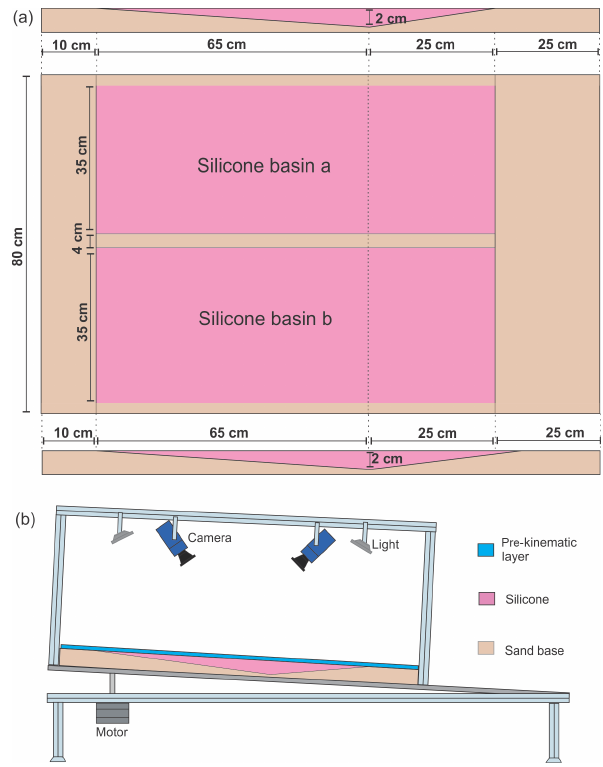
Figure 2. Experimental setup and sketch of the apparatus. (a) Ex- perimental setup including two identical silicone basins in each ex- perimental run. The double-wedge shape of the silicone basin is 2cm at its deepest. (b) 2-D sketch of the experimental setup. The cameras are attached to the tilting basal plate lifted by a stepper